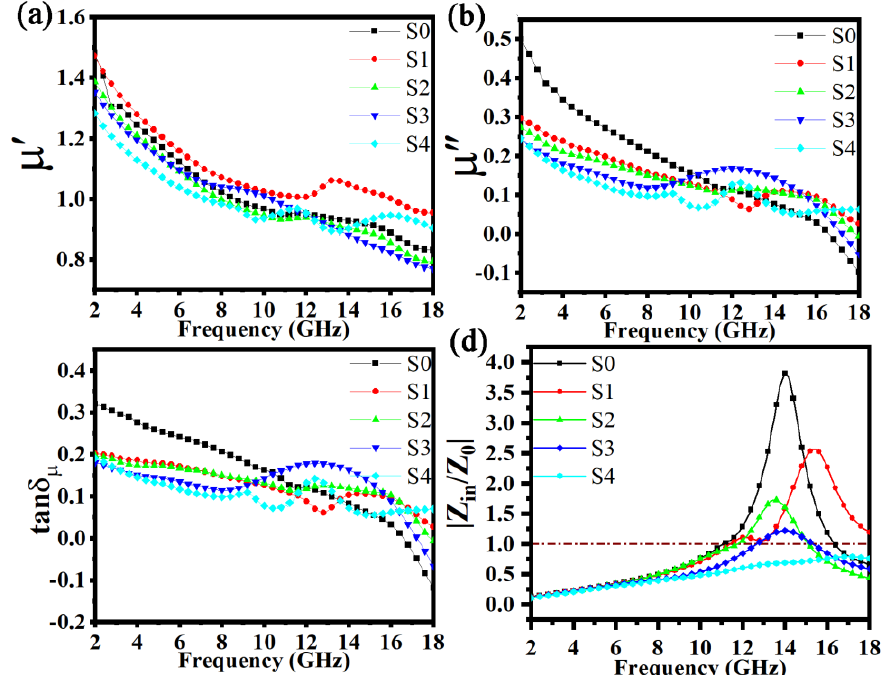
Figure 9. Frequency dependence of the FeSiAl and FeSiAl@HC samples: ( a ) μ ′− f , ( b ) μ ″− f , ( c ) tanδ μ − f , and ( d ) Z in /Z 0 − f .